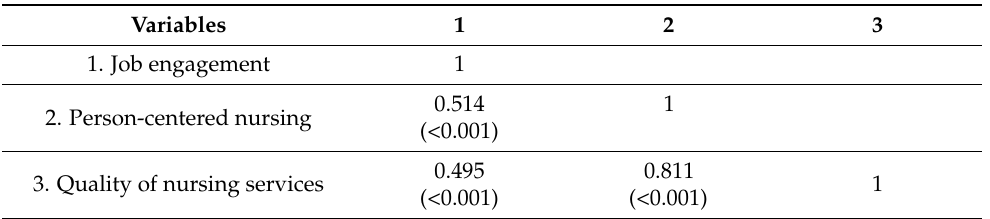
Table 3. Correlation among job engagement, person-centered nursing, and quality of nursing services ( N = 200).